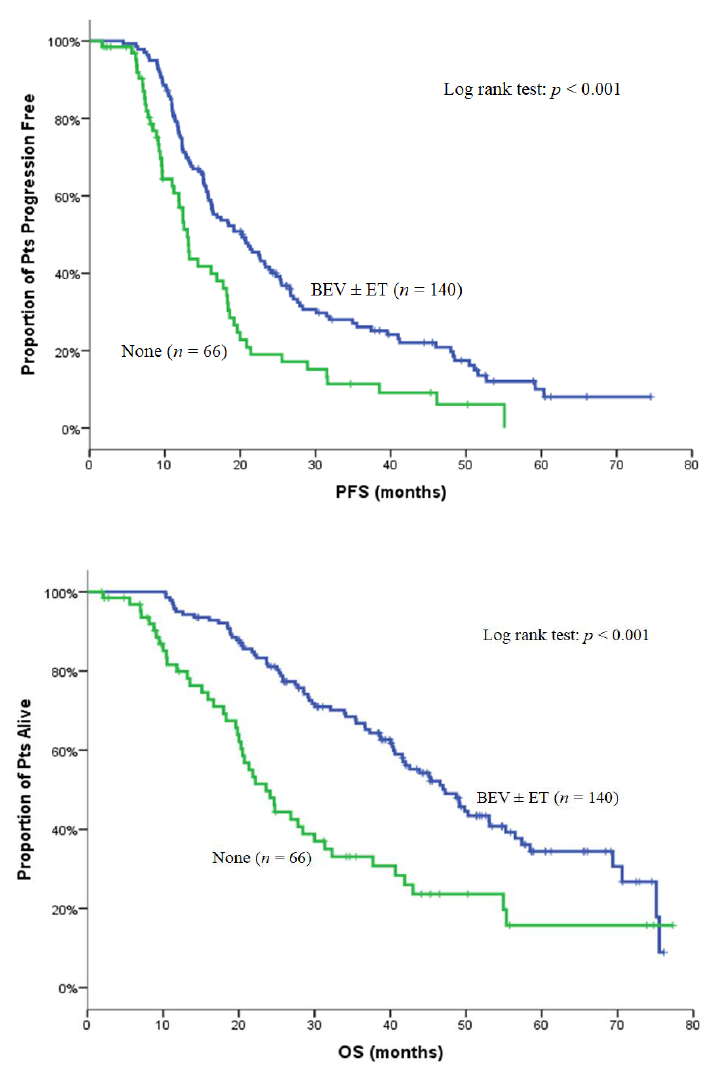
Figure 4. Kaplan–Meier curve for PFS and OS in HR -positive patients without disease progression, according to maintenance treatment (bevacizumab ± endocrine therapy versus no maintenance).